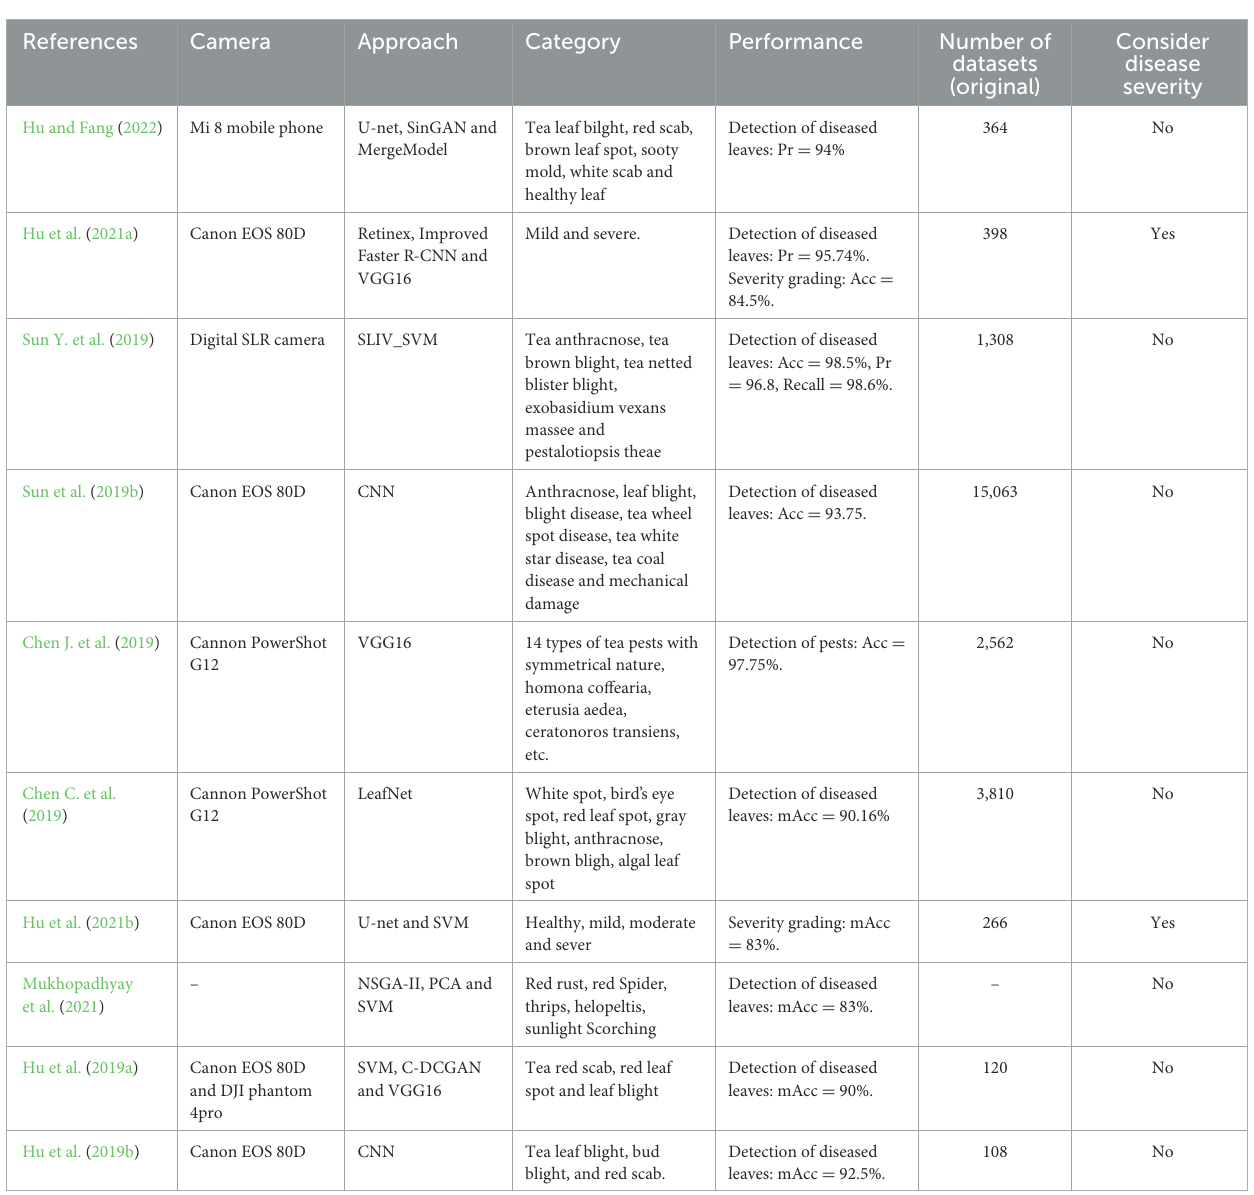
TABLE 3 Summary of the application of computer vision and machine learning for tea disease